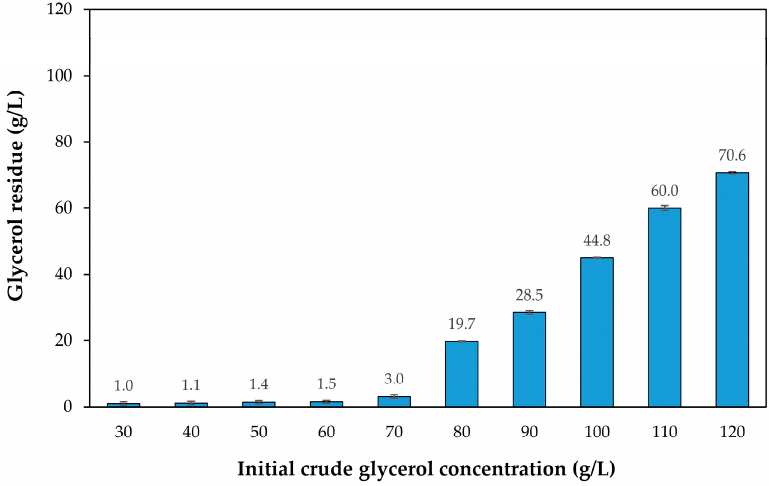
Figure 2. The amounts of glycerol residues in the medium containing different crude glycerol concentrations (30–120 g / L) after 240 h cultivation of Rhodosporidiobolus fluvialis DMKU-SP314 in a shake flask culture at 28 °C and 150 rpm.